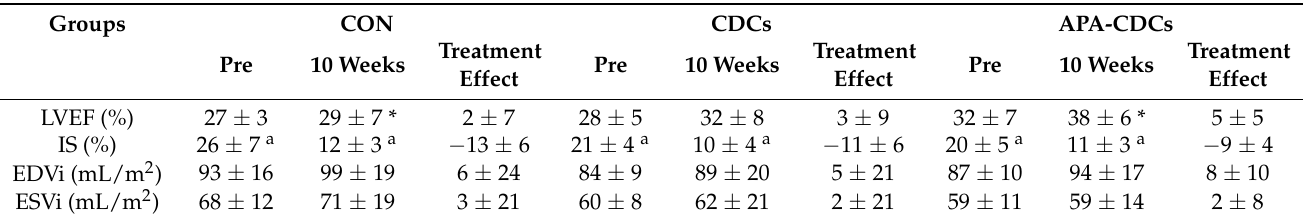
Table 2. MRI-derived cardiac function parameters measured before (pre) and 10 weeks after IP treatment, as well as treatment effects.